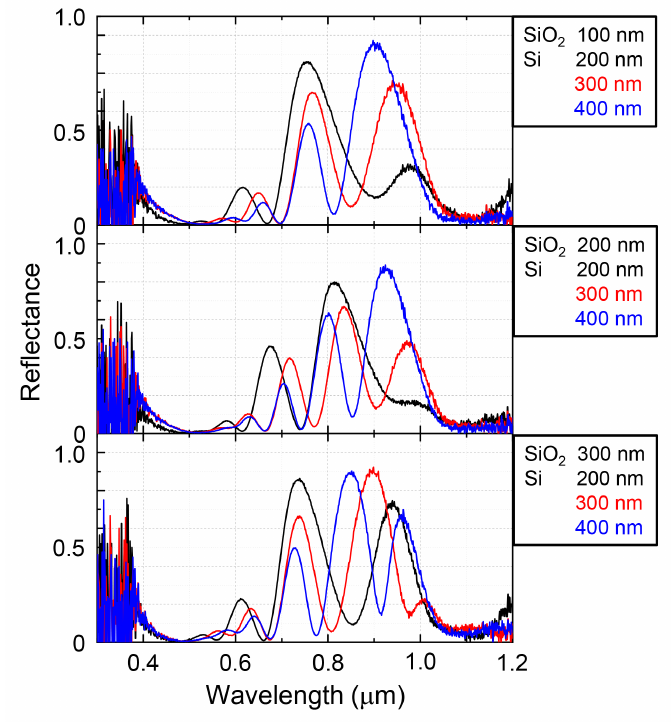
Figure 2. Reflection spectra of black metals from visible to near-IR wavelength range for different thickness of SiO 2 and